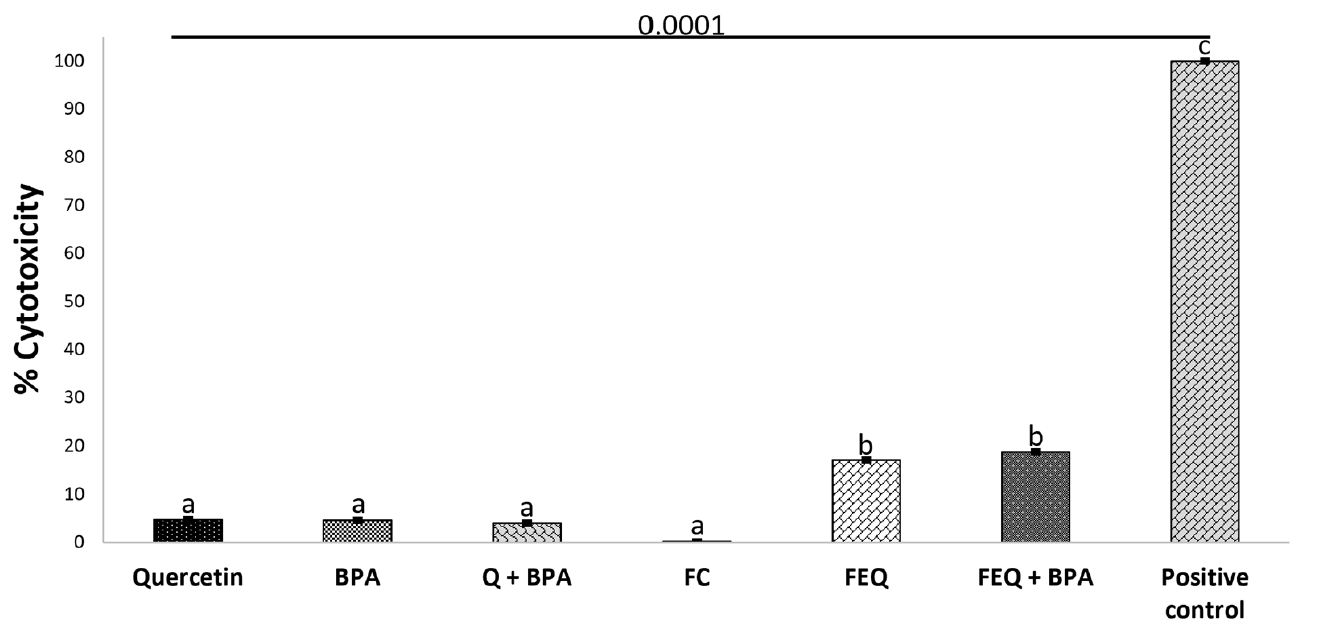
Figure 6. Cytotoxicity (%) effect of Q and FEQ on HT-29 colon cancer cells treated with BPA. Concentration of treatments: Q 160 µ M, BPA 4.4 µ M, FEQ 16%. FC: fermentation control. Each